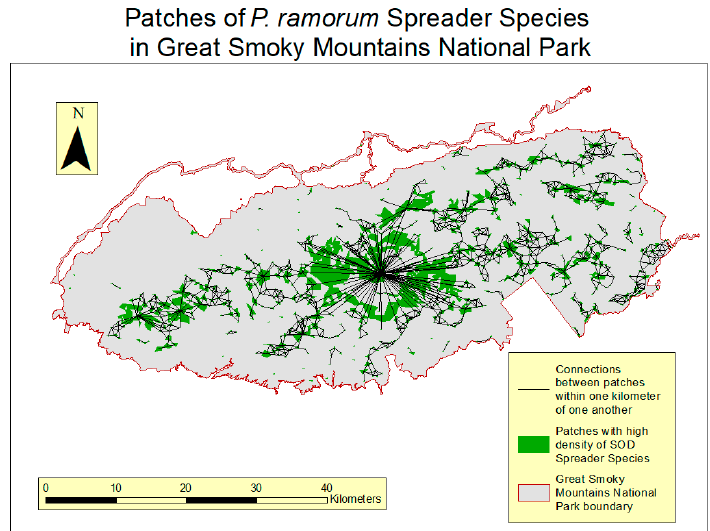
Figure 7. Patches with very high density of spreader species for P. ramorum in the Great Smoky Mountains National Park. Black lines connect the centroids of patches where edge-to-edge distance is less than 1 km.